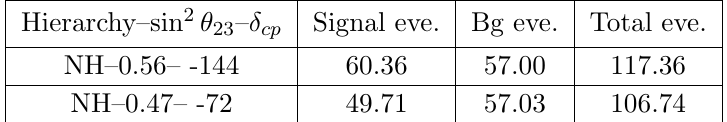
Hierarchy{sin 2 (cid:18)